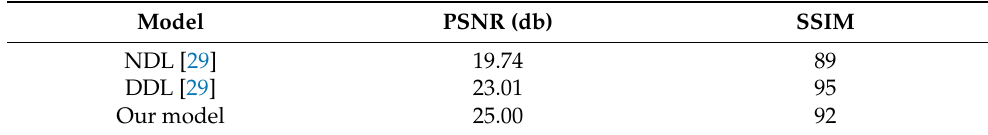
Table 1. PSNR and SSIM comparison.